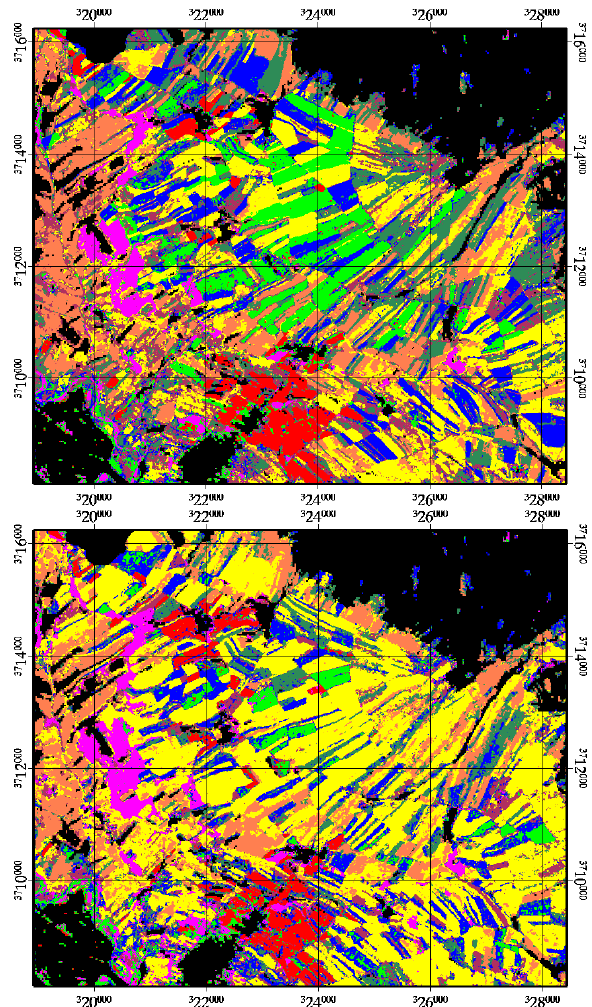
Figure 6 : Classification map of the year 2012 (on the top) and 2013 (on the